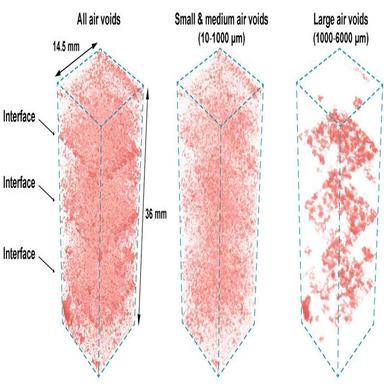
3D visualization of the air voids in the 3D printed sample obtained by using CT scanning, adapted from Ref..